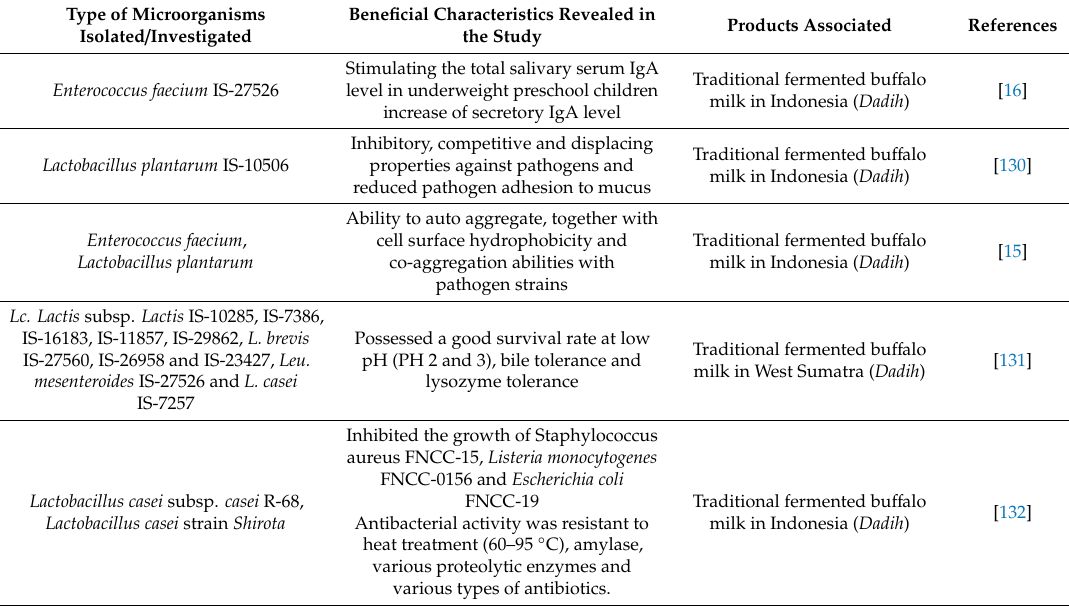
Table 5. Health benefits of probiotic bacteria isolated from fermented bu ff alo